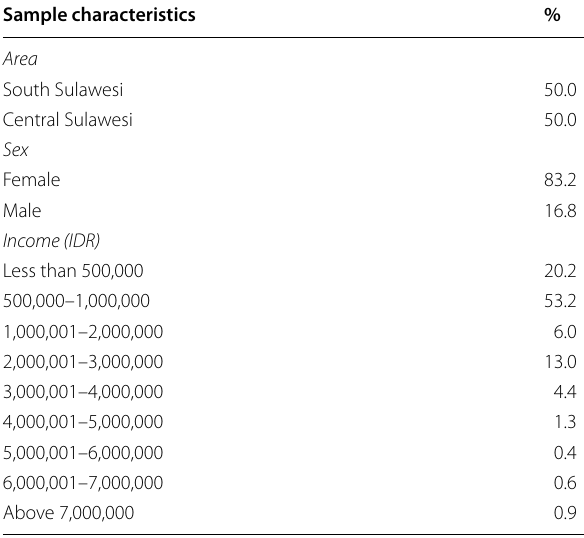
Table 1 Sample characteristics (n